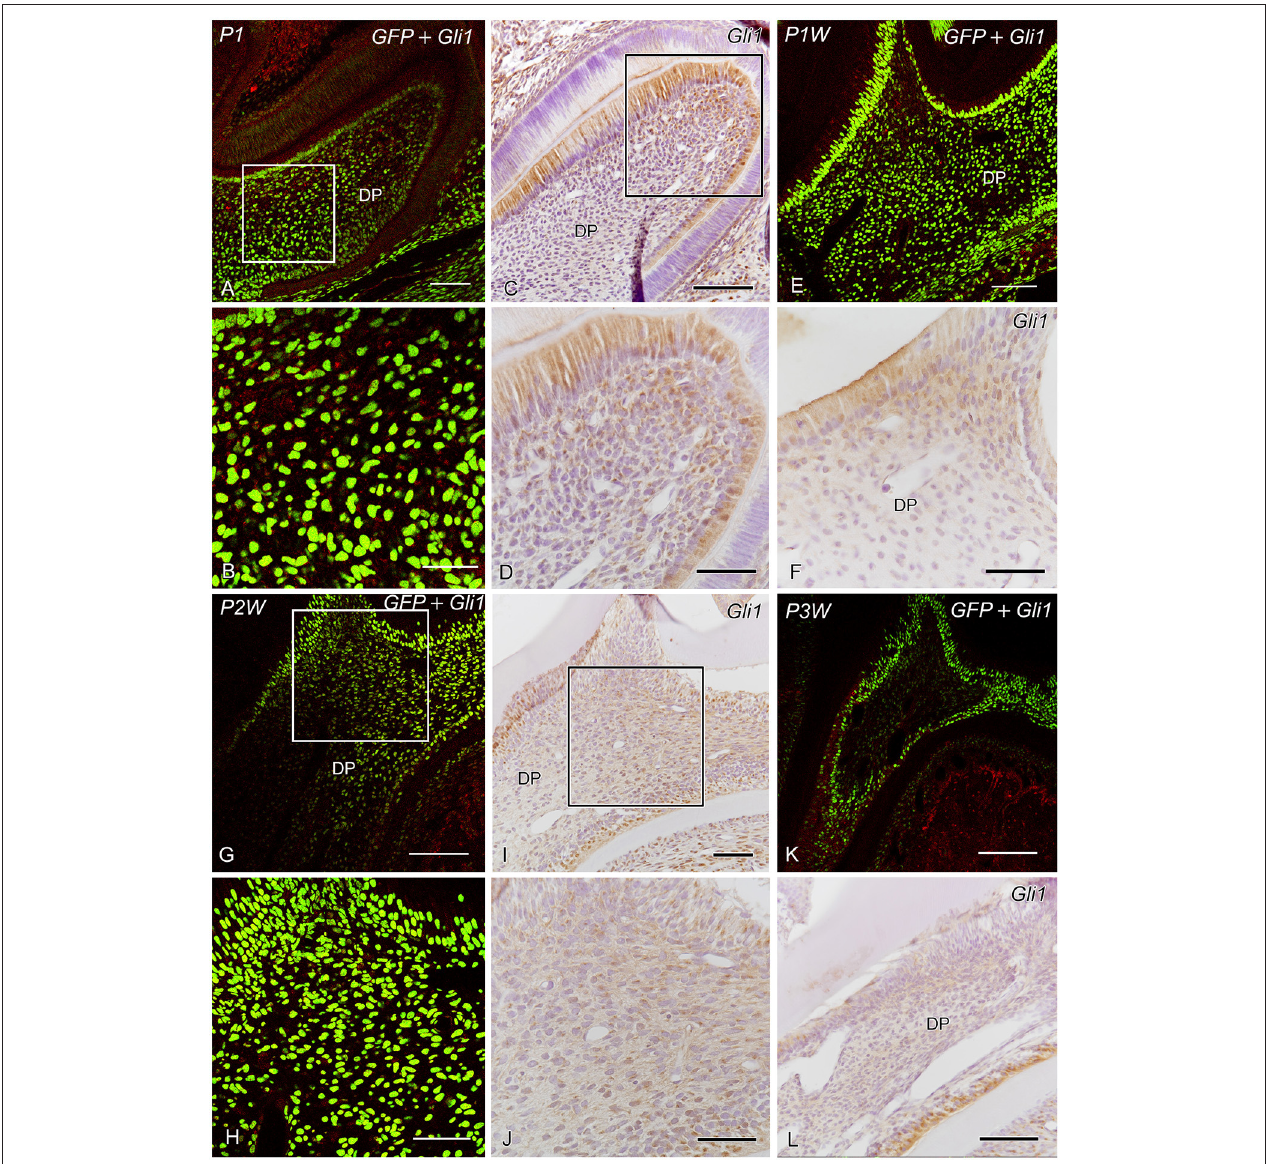
FIGURE 2 | GFP expression and Gli1 IR (A,B,E,G,H,K) and Gli1 IR (C,D,F,I,J,L) in the developing molars at postnatal day 1 (P1) (A–D) , P1W (E,F) , P2W (G–J) , and P3W (K,L) ( DP dental pulp). (A,B,E,G,H,K) Dense GFP + cells are observed throughout the dental pulp during P1–P2W and decrease in number at P2W, whereas the number of dense GFP + cells in the subodontoblastic layer increases in number at P2W. In contrast, granular GFP + cells increase in number at P3W in the dental pulp. (B,D,H,J) Higher magnification of the boxed areas in panels (A,C,G,I ). (A–L) Gli1 + cells are distributed throughout the enamel organ and dental pulp, including the odontoblast and subodontoblastic layers. Scale bars: 100 µ m (A,C,E,G,I,K,L) and 50 µ m (B,D,F,H,J)